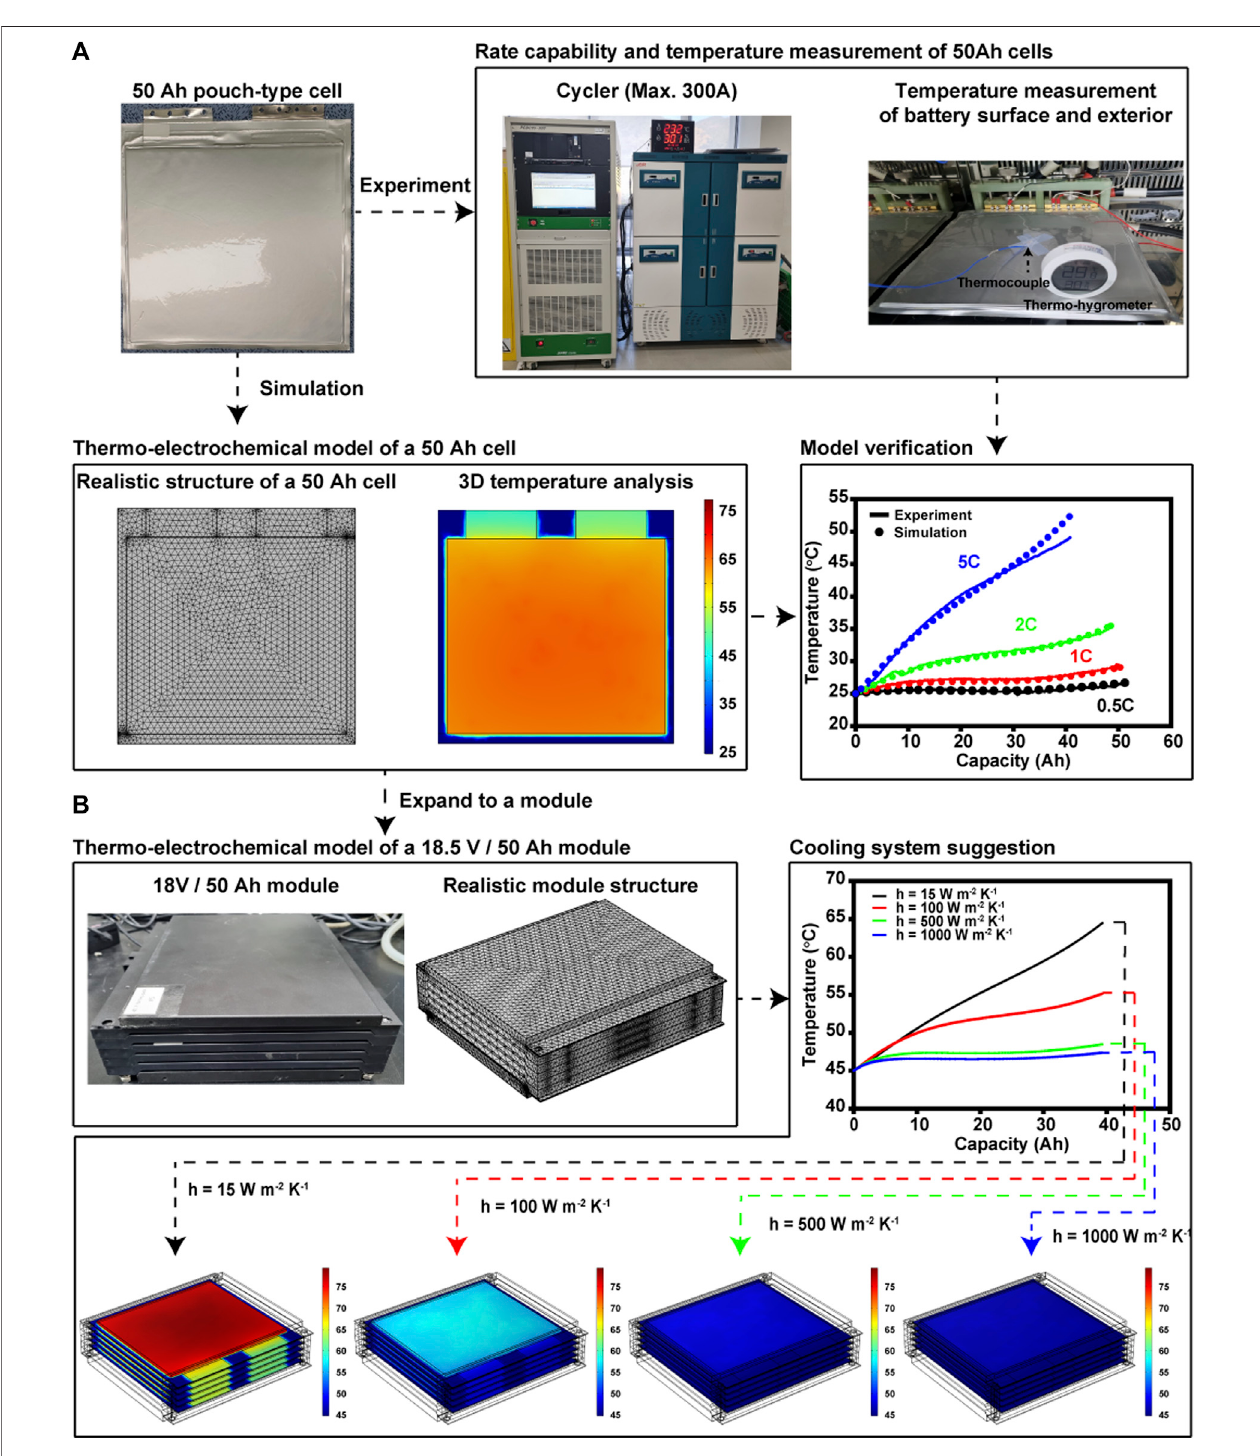
FIGURE 1 | A thermo-electrochemical model development process from (A) a 50 Ah cell model with experimental proof to (B) an 18.5 V/50 Ah module model.